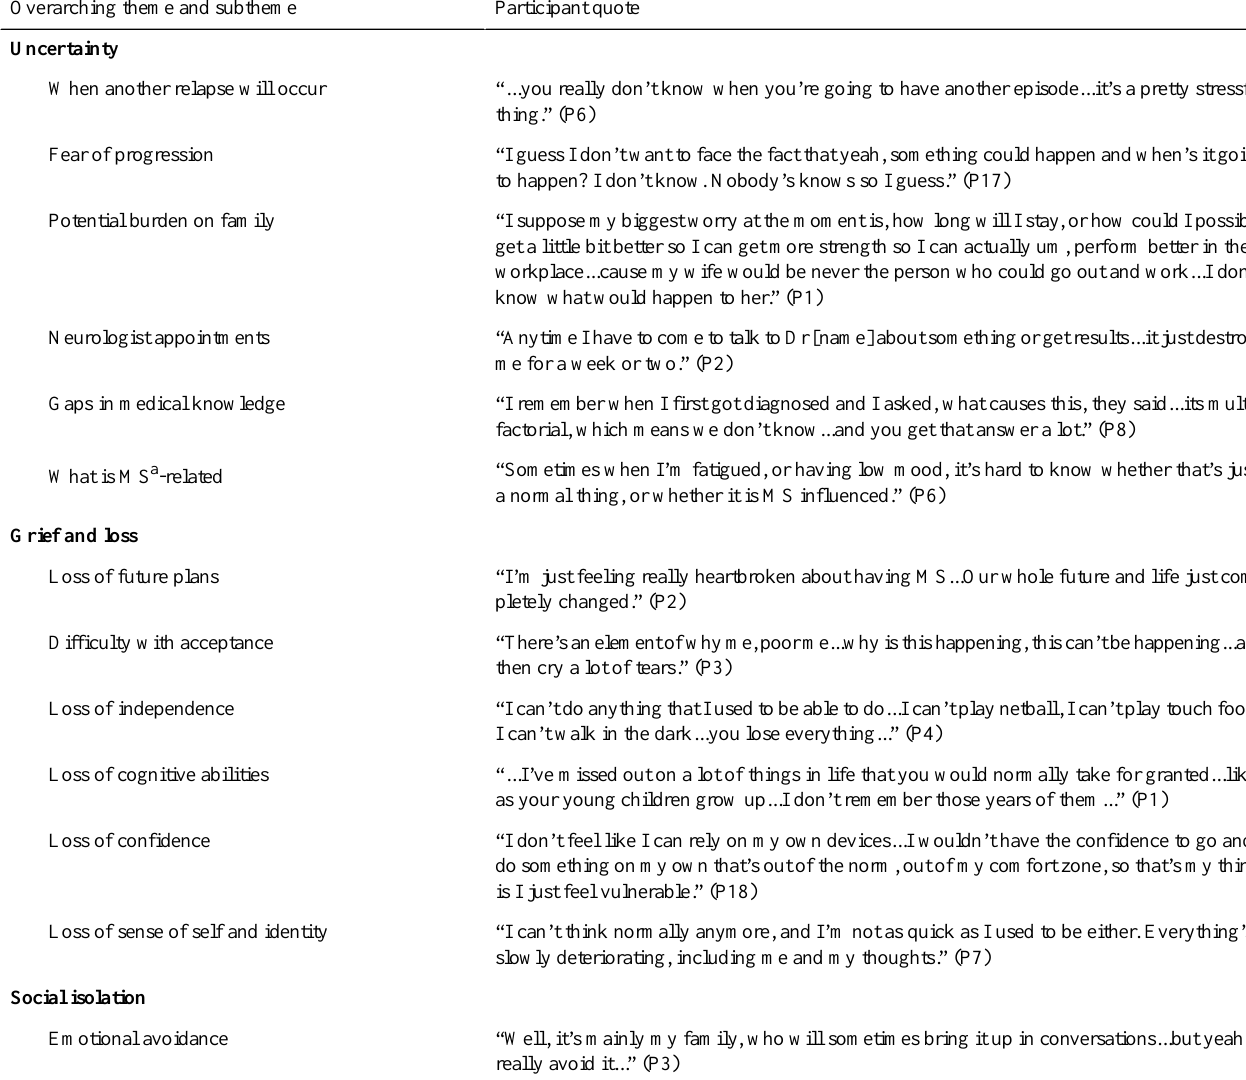
Participant quoteOverarching theme and subtheme